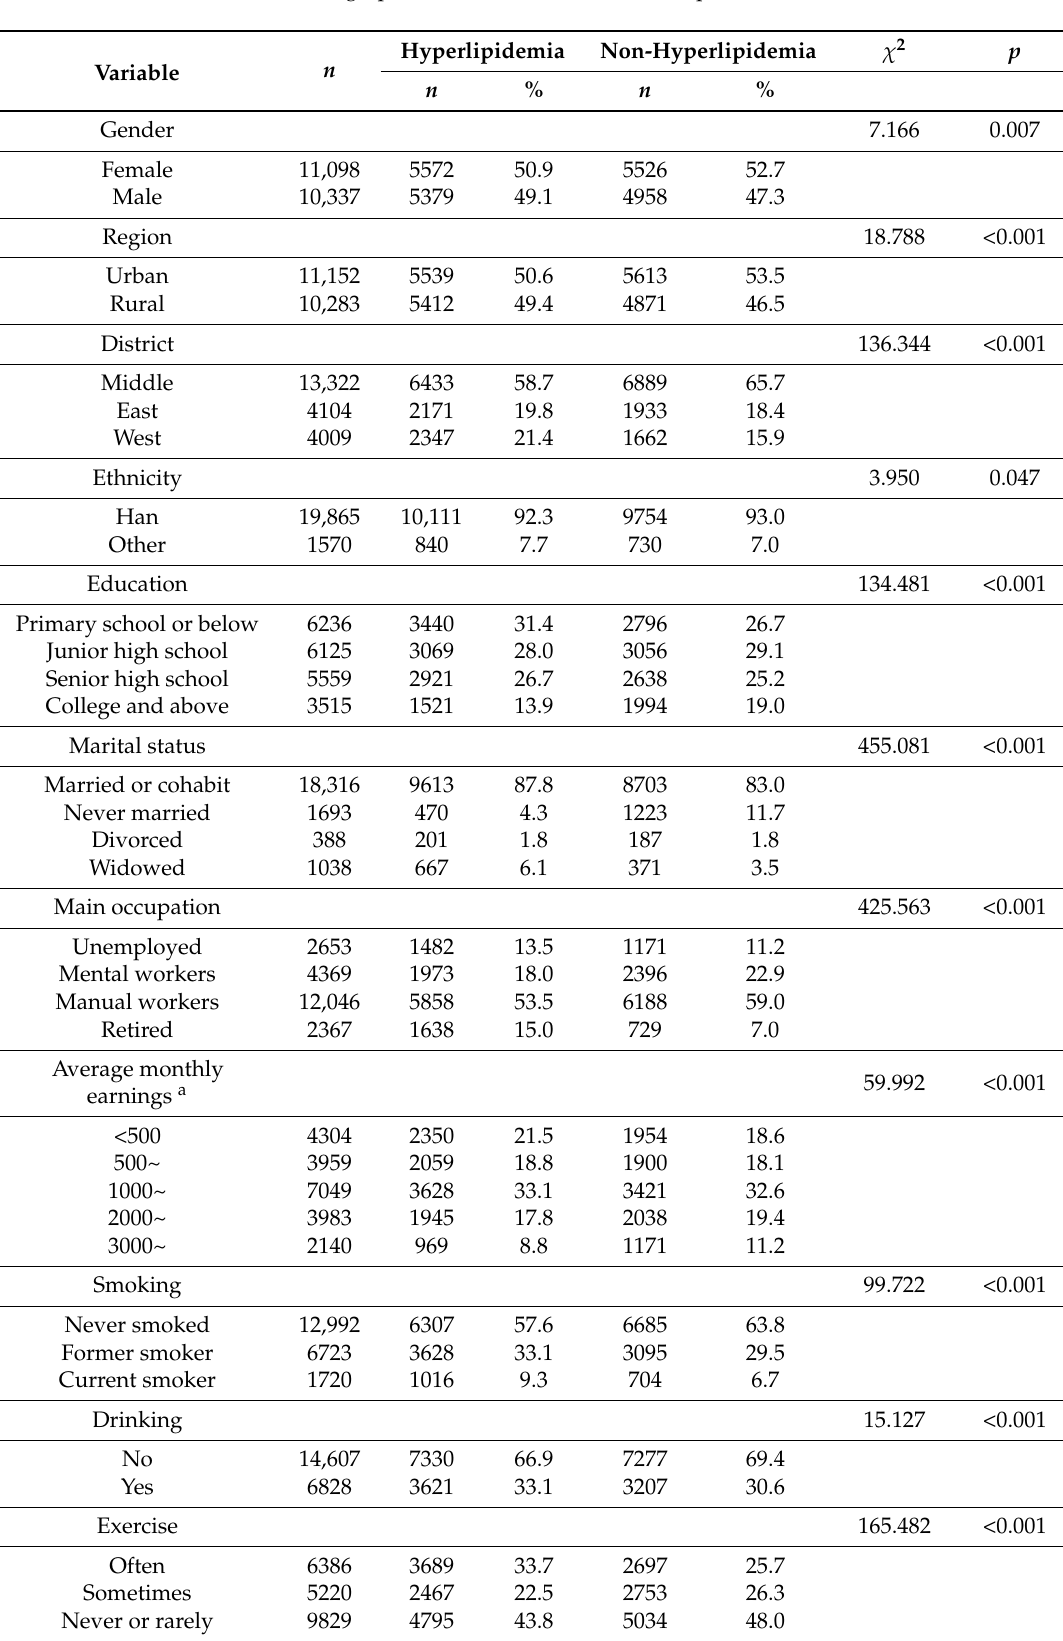
Table 1. Demographic characteristics of adult samples ( n =